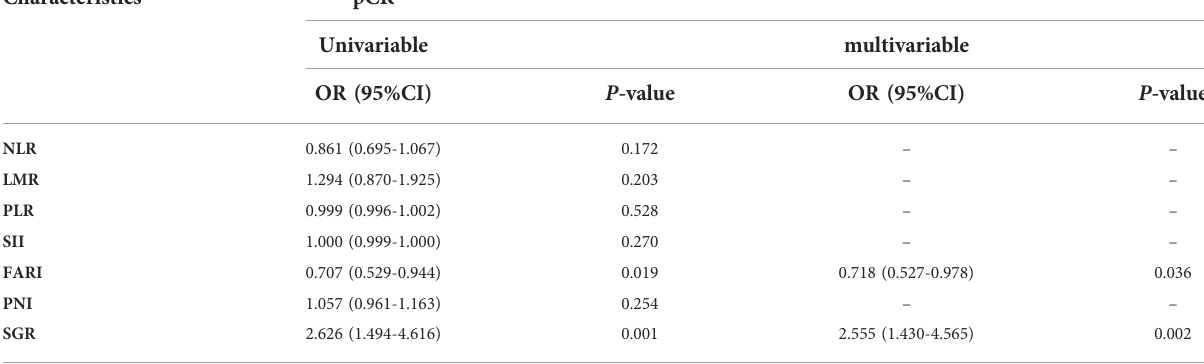
TABLE 3 Univariate and multivariate logistic regression analyses for blood parameters.